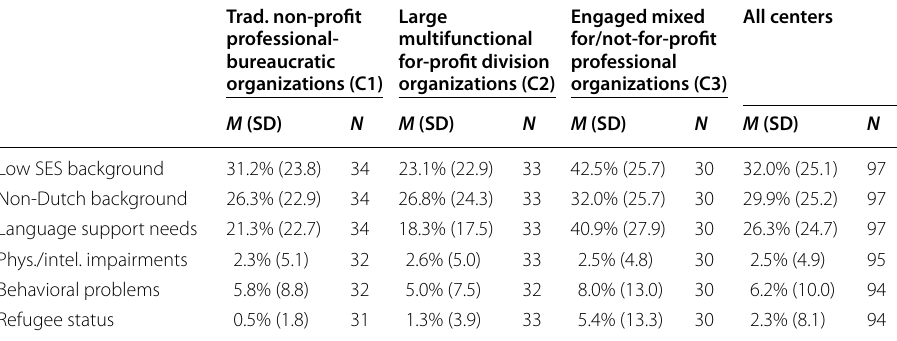
Table 4 Teacher-reported group composition characteristics (partly overlapping) by organizational configuration